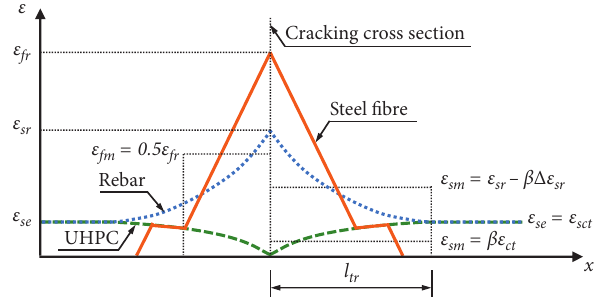
Figure 13: Strain distribution in the UHPC, steel fibre, and